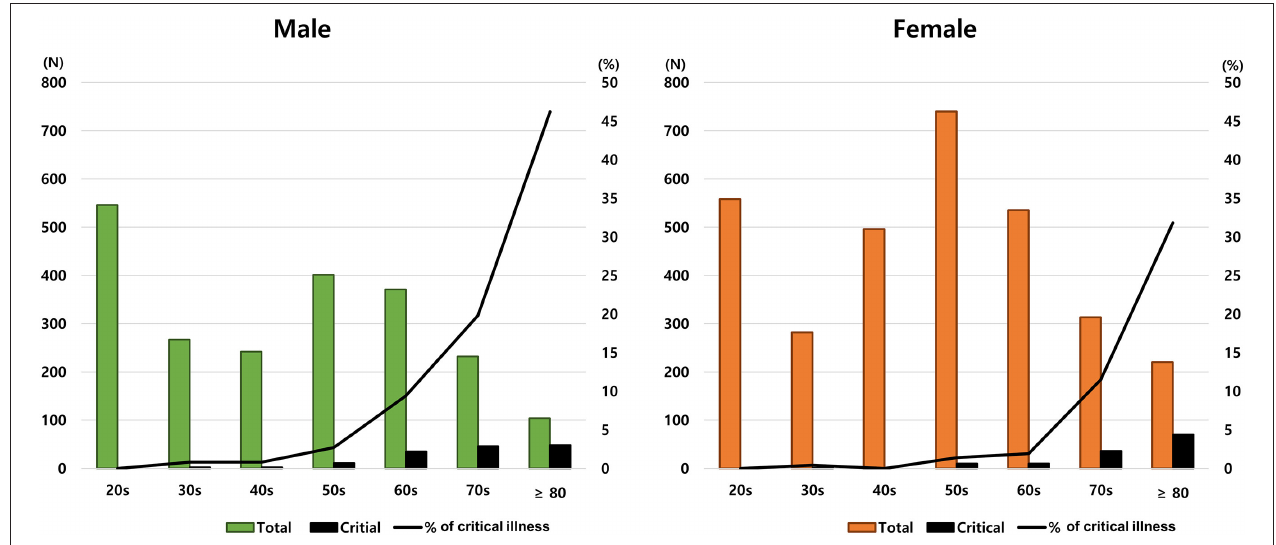
FIGURE 2 | Proportion of critical illness according to age and